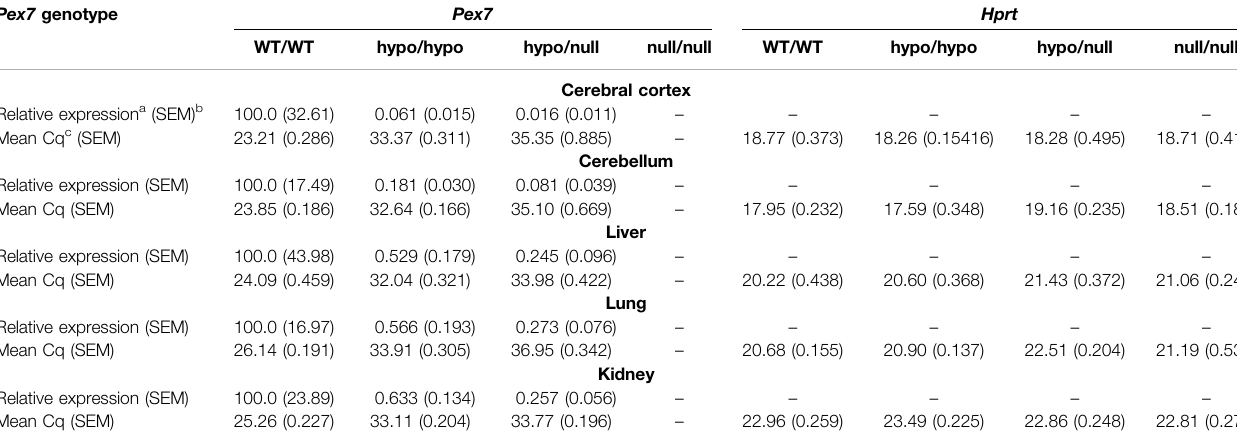
TABLE 1 | Pex7 transcript levels according to the genotype severity of Pex7 de fi cient mice.